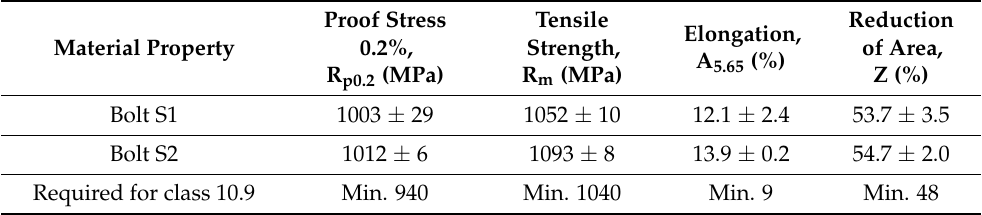
Figure 15. Stress-strain curves obtained for three specimens taken from the S2 bolt. Table 2. Summary of the material properties that were obtained from stress-strain curves, and also the requirements according to the EN ISO 898-1